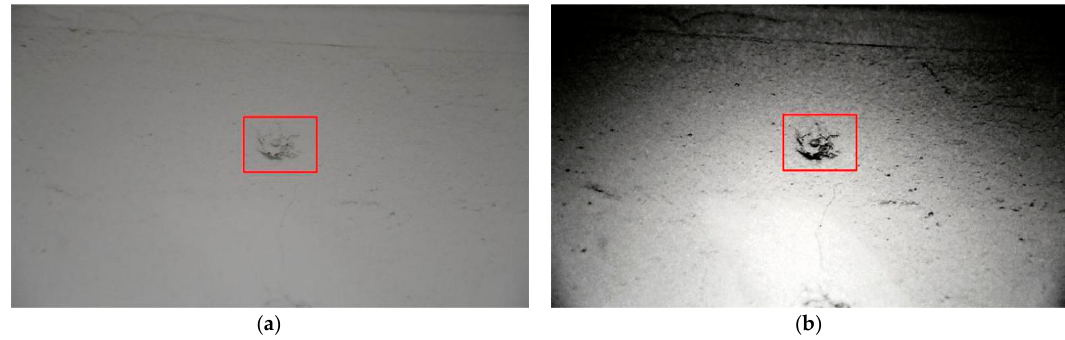
Figure 2. Effects of preprocessing: ( a ) Original image; ( b ) Preprocessed image.